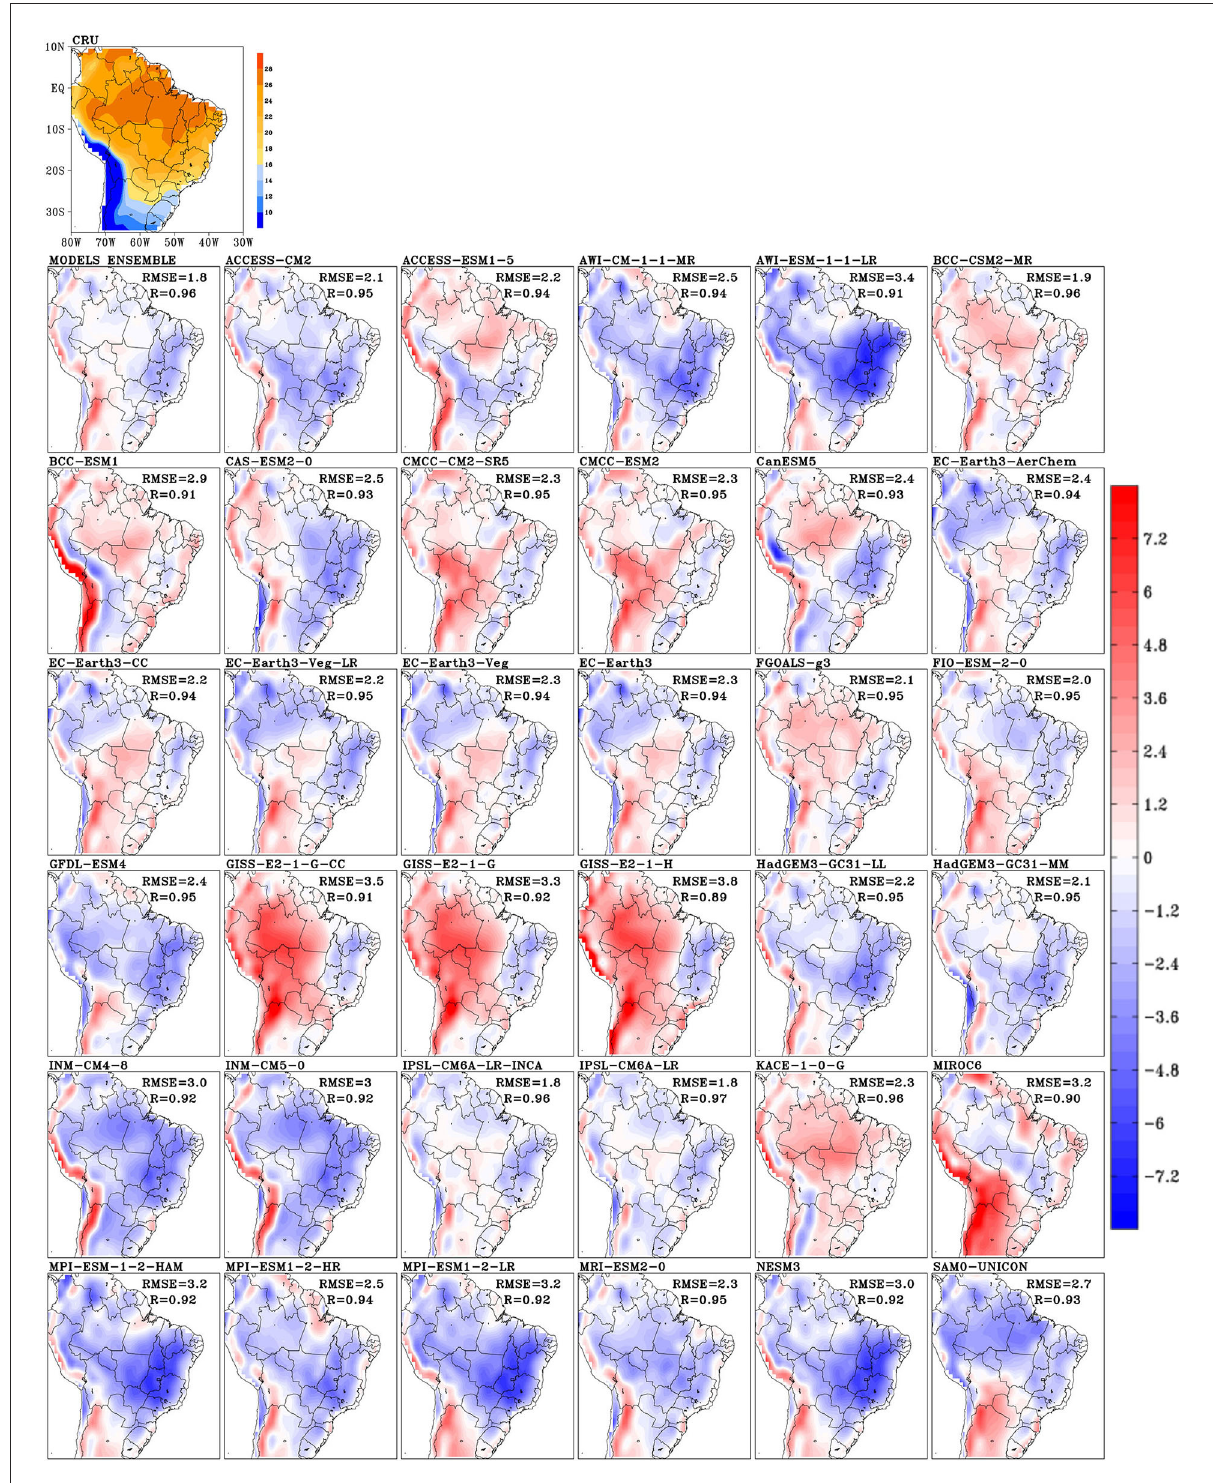
FIGURE9 CMIP6 model biases and CRU-observation (top left panel) for surface air temperature: Austral winter (JJA). Unit: ◦